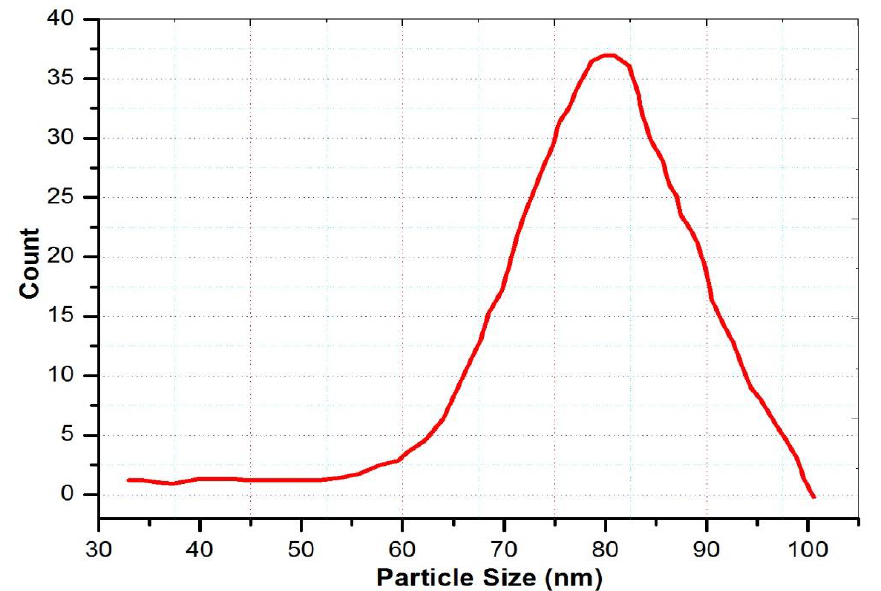
Figure 5. Particle size distribution histogram of zeolite imidazole framework (ZIF-8).